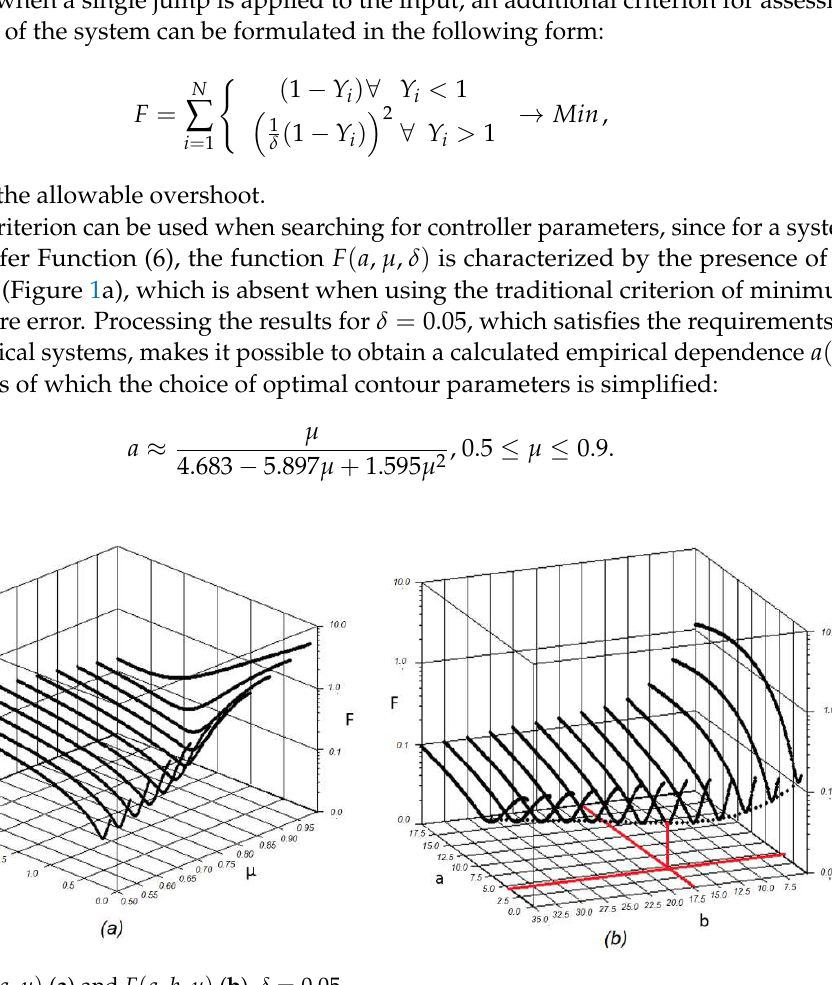
Figure 1. F ( a , µ ) ( a ) and F ( a , b , µ ) ( b ), δ = Figure 1. .